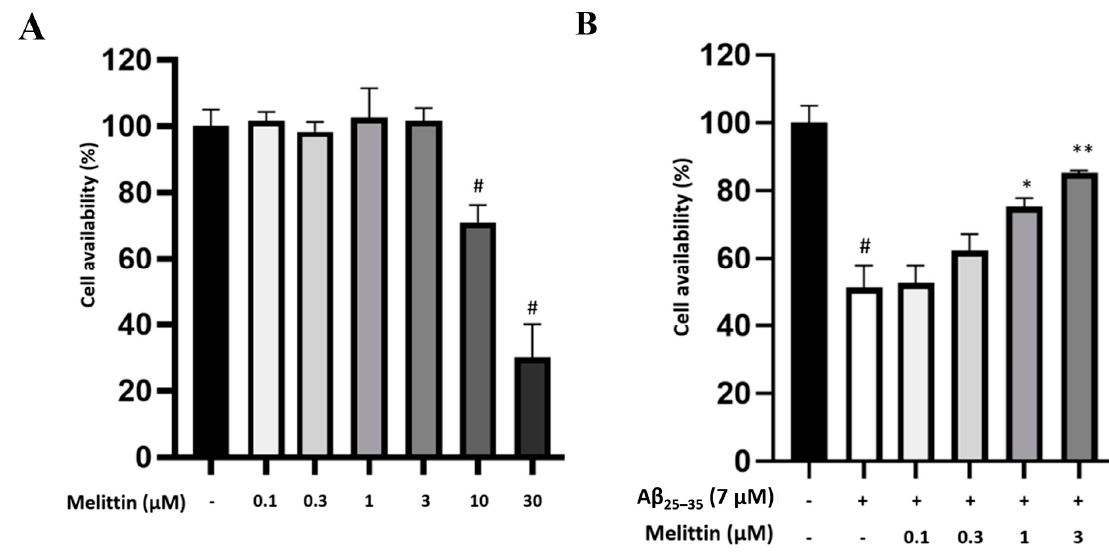
Figure 1. Screening for melittin maximum safety dosage and melittin protective effect against A β 25–35 stress induced in HT22 cells. ( A ) Screening for maximum melittin safety concentration. The result indicated that 3 μ M was the highest safety concentration of melittin to be studied. To conduct this experiment: Cells were seeded in 96-well plates; after incubation for 24 h, Melittin at different concentrations was introduced, and cell availability was examined after 24 h of incubation. ( B ) Protective effect of melittin against A β 25–35 stress. The result indicated that 0.3 to 3 μ M melittin was found to dosage-dependently ameliorate HT22 cell availability. To conduct this experiment: Cells were seeded in 96-well plates; after incubation for 24 h, melittin from 0.1 to 3 μ M was introduced 1 h before A β 25–35 (7 μ M) challenge, and cell availability was examined after 24 h of incubation. Data are presented as the mean ± standard deviation values of triple determinations. # p < 0.01 vs. control * p < 0.05 and ** p < 0.01 vs. A β 25–35 only-treated group.